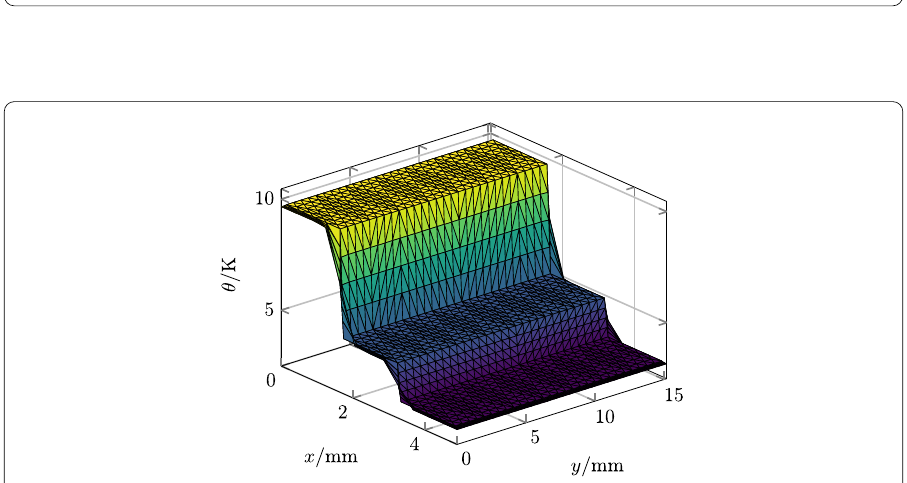
Figure 8 Temperature distribution in the Rutherford cable at z = z q = 0.33 m at time t = 10